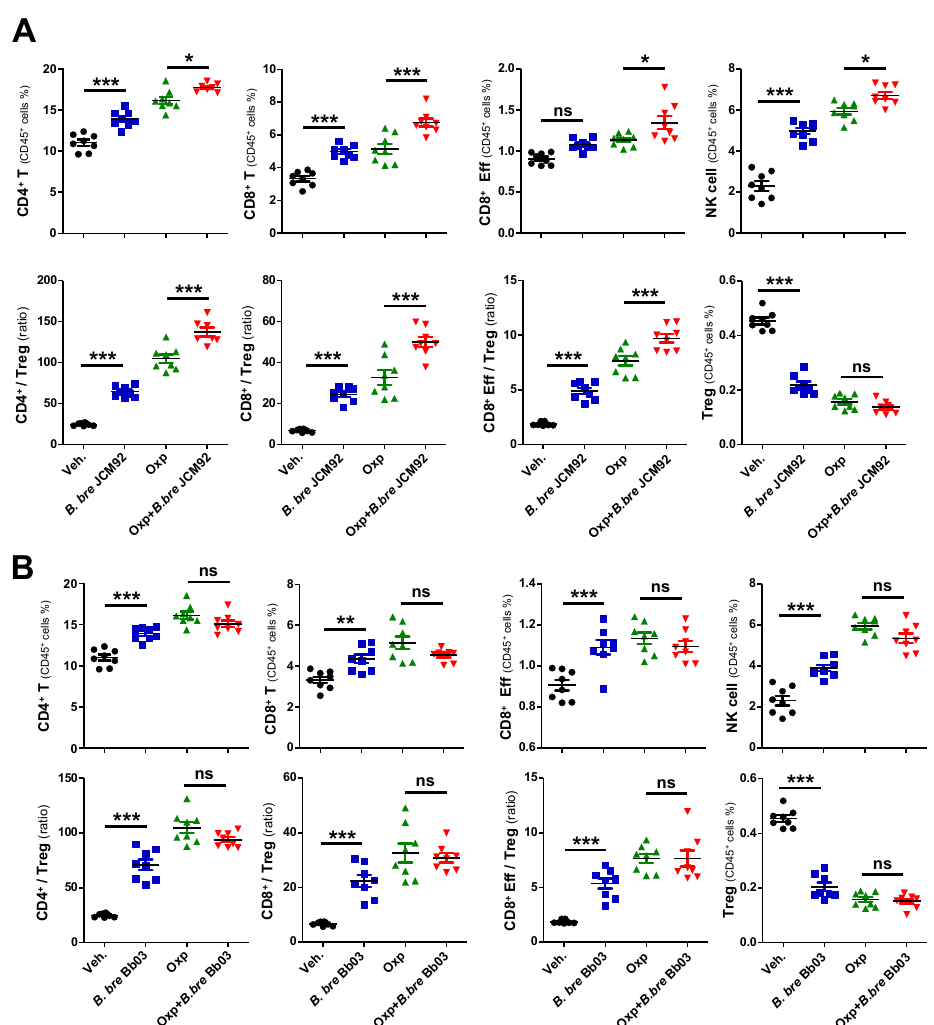
Figure 2. B. bre JCM92 boosts oxaliplatin efficacy by enhancing anti-tumor immunity in the spleen. ( A , B ) Immune cell profiling of the spleen in mice treated with oxaliplatin in combination with B. bre JCM92 ( A ) or B. bre Bb03 ( B ) using flow cytometry analysis. Data are expressed as the means ± SEM. p -values were determined by one-way ANOVA using Tukey’s post-test. * p < 0.05, ** p < 0.001, *** p < 0.001, and ns, not significant.